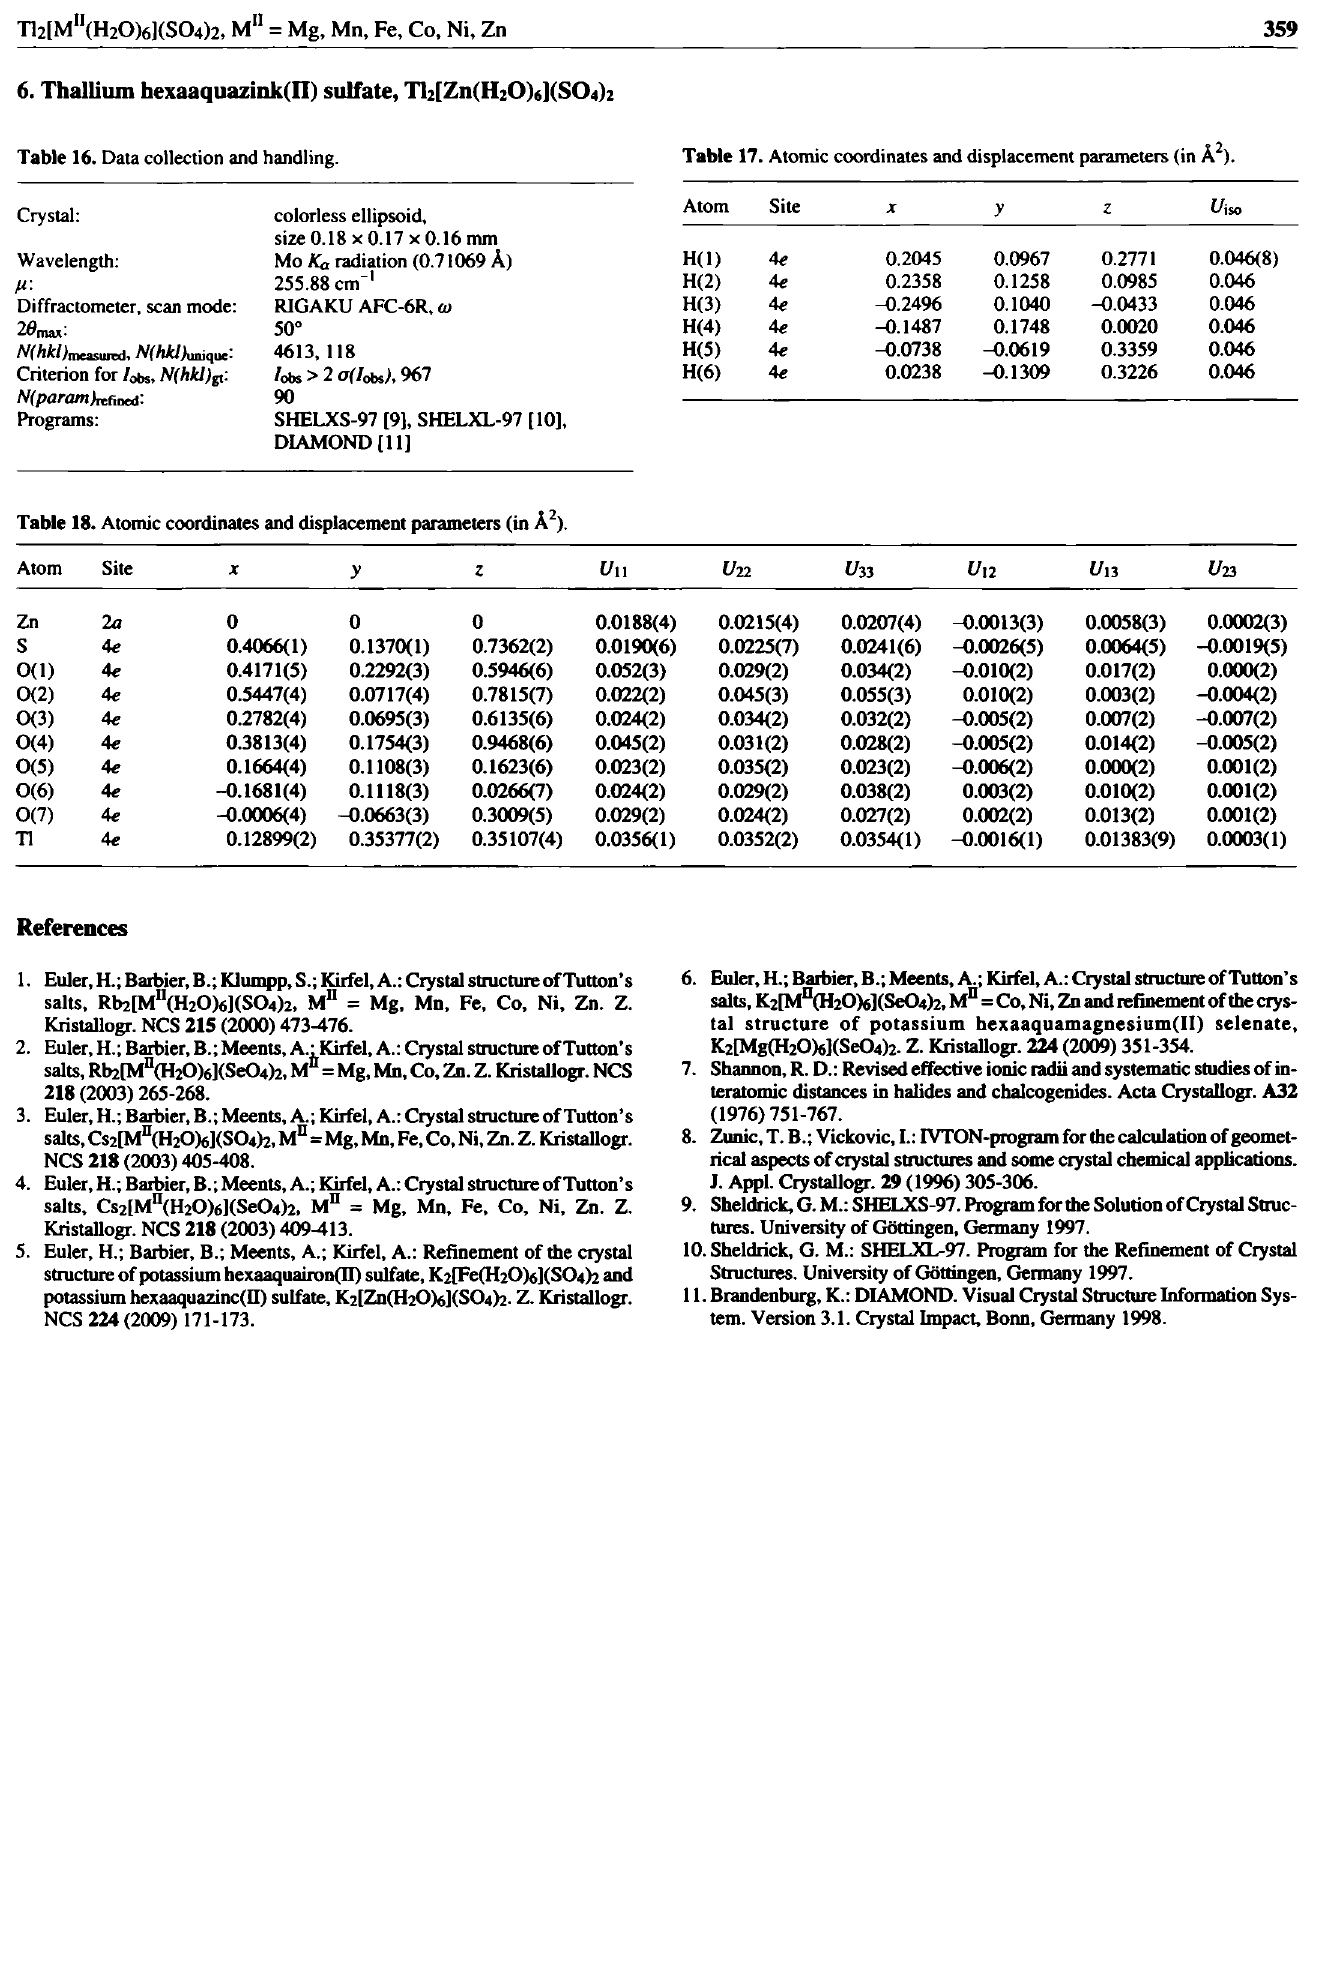
Table 16. Data collection and handling. Table 17. Atomic coordinates and displacement parameters (in A 2 ).